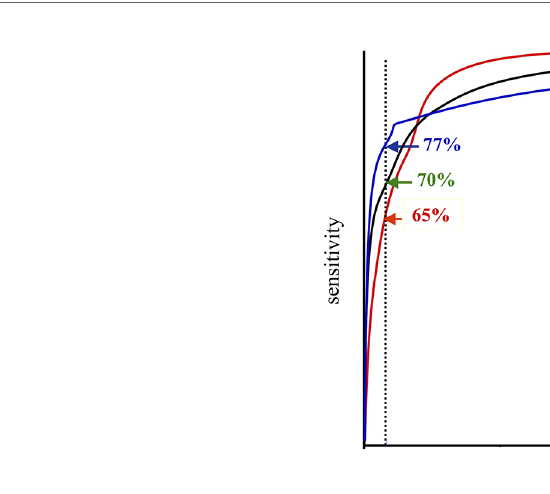
FIGURE 3 | When diagnostic sensitivities are compared between different tests, they should be aligned to the same diagnostic speci fi city, preferably in the high speci fi city range. In this schematic fi gure, the Area Under the Curve (AUC) is highest for the red and lowest for the blue Receiver Operator Characteristics (ROC) curve. However, at the prede fi ned diagnostic speci fi city (vertical dotted line) the blue ROC curve represents the test with the highest sensitivity, which should be preferred when laboratory results are reported in relation to one single cutoff. The original picture was obtained from Allan Wiik, Copenhagen, and published in modi fi ed form with his